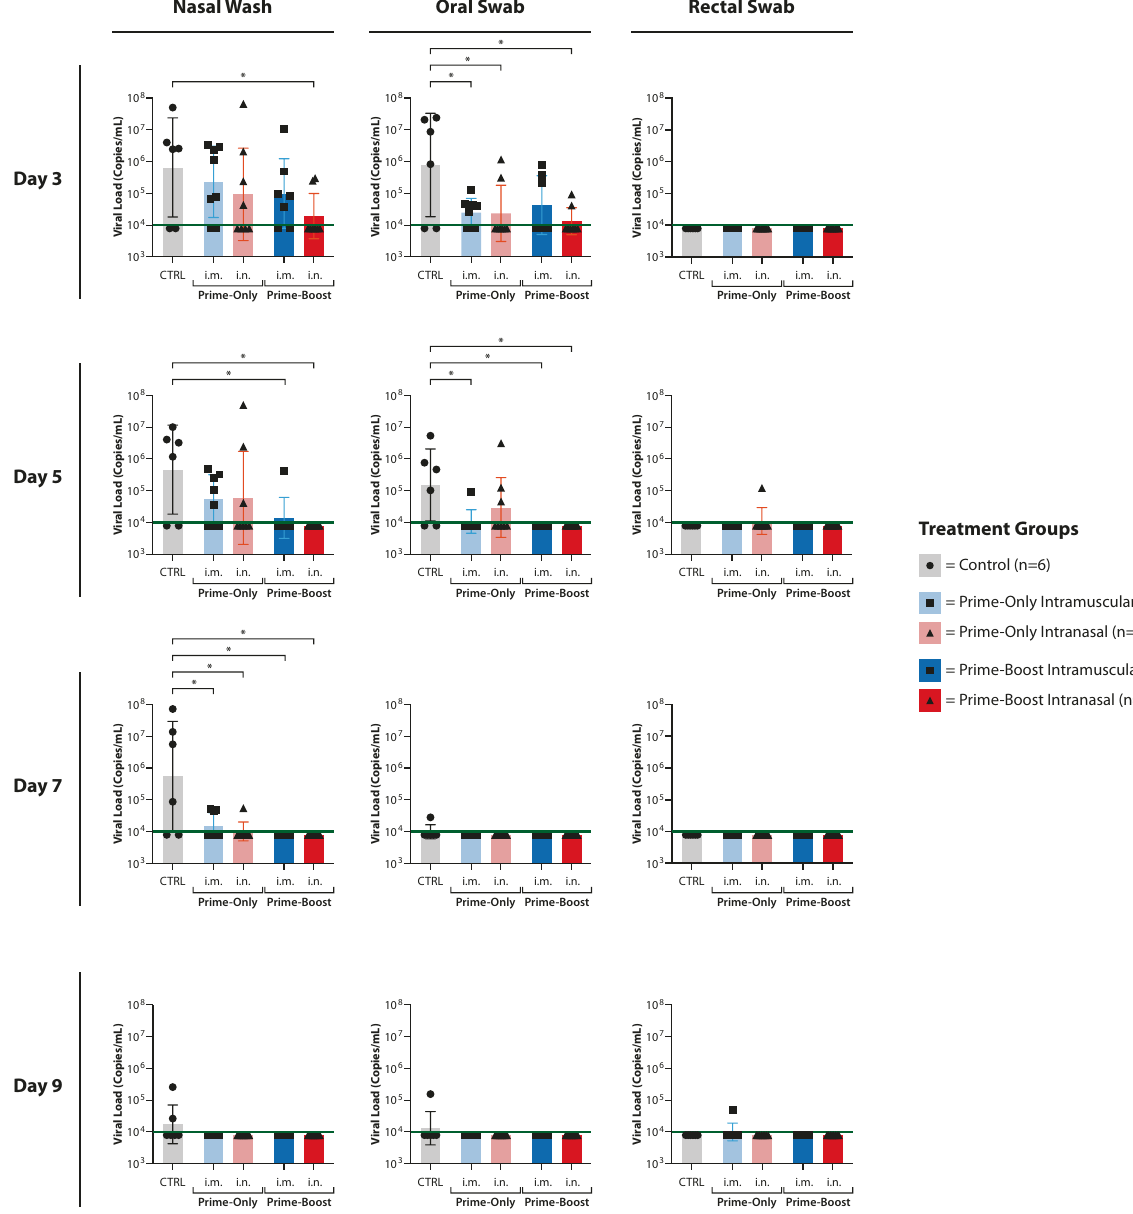
Fig. 5 Viral load in nasal-wash and rectal and oral swab fl uids as determined by RT-qPCR. RNA was extracted from samples collected on days 3, 5, 7 and 9 post challenge (study days 31, 33, 35 and 37 for prime-only animals; days 59, 61, 63 and 65 for prime-boost animals), and was analysed in duplicate using RT-qPCR assay detecting SARS-CoV-2 E RNA. Black points represent mean RNA copy number of the duplicate reactions for individual ferrets. The columns represent mean RNA copy numbers for each group, error bars represent SEM and the green lines are the limit-of-detection for the assay. Where no viral RNA was detected by RT-qPCR, a data point has been plotted at 3.9. Statistical analysis was performed by one-tailed t test, with statistical signi fi cance indicated by an asterisk ( P < 0.05).